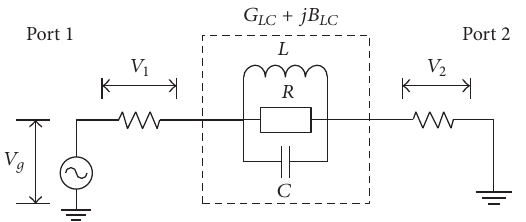
Figure 5: 𝑅𝐿𝐶 equivalent circuit for unit DGS